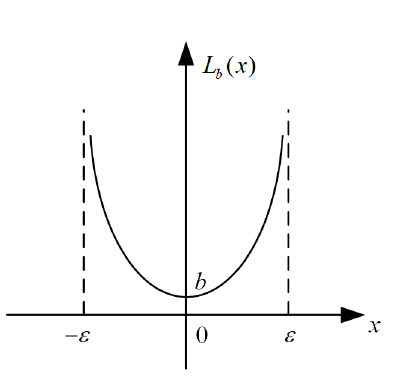
Figure 2. The barrier function (7).